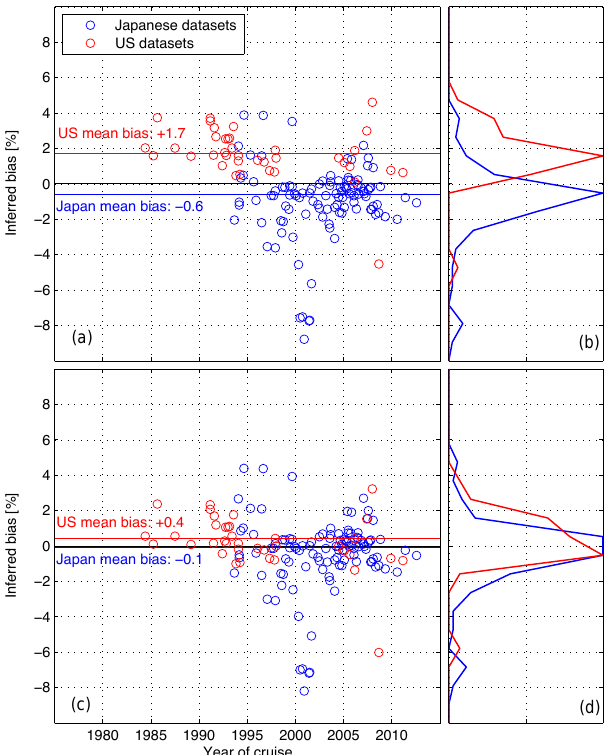
Figure 4. Silicate biases between US and Japanese efforts before (a, b) and after (c, d) pre-adjustments (US: − 1%; Japan: + 1%) were applied to the data (see main text for details). Data from “Line P” and many small-scale cruises in the variable Kuroshio region were excluded from this analysis. Red and blue horizontal lines in- dicate countries’ approximate mean